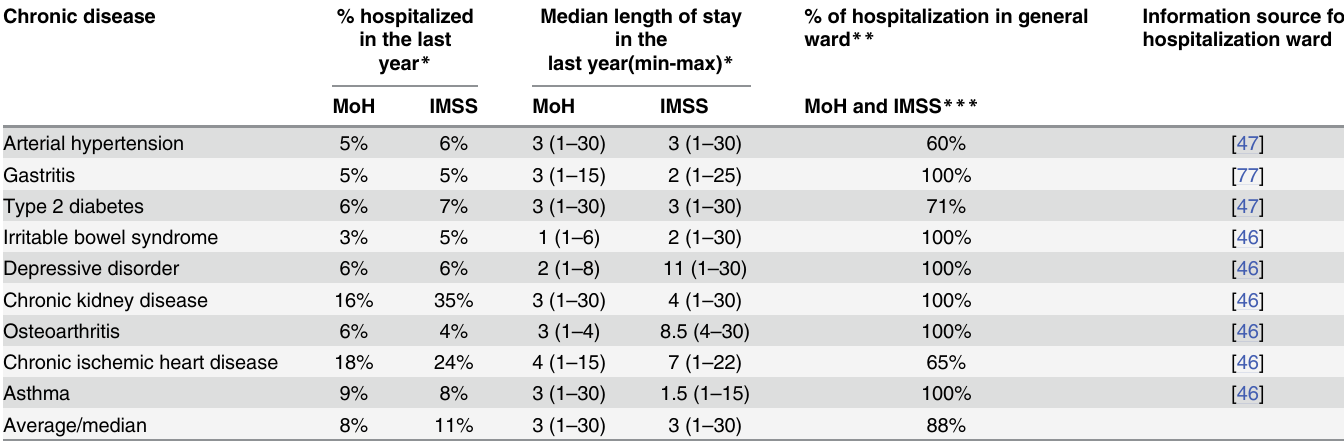
Table 2. Reported hospitalization by insured diagnosed with a chronic disease in ENSANUT, by health